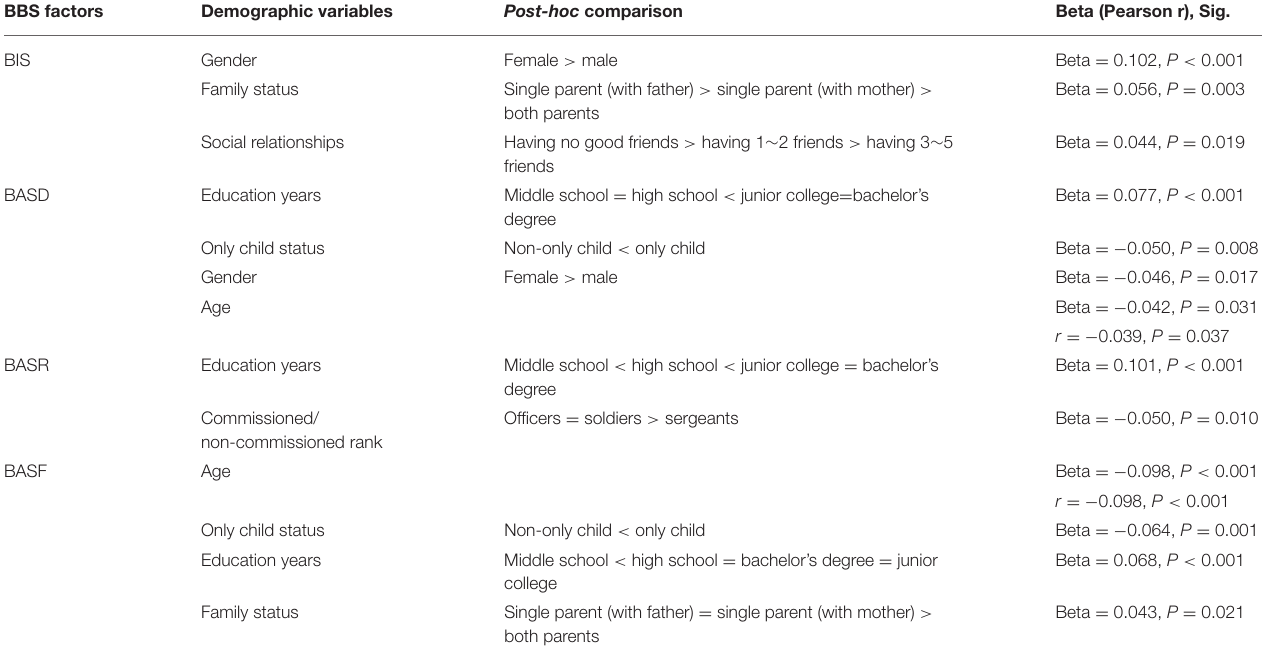
TABLE 5 | Effects of demographic characteristics on approach/avoidance